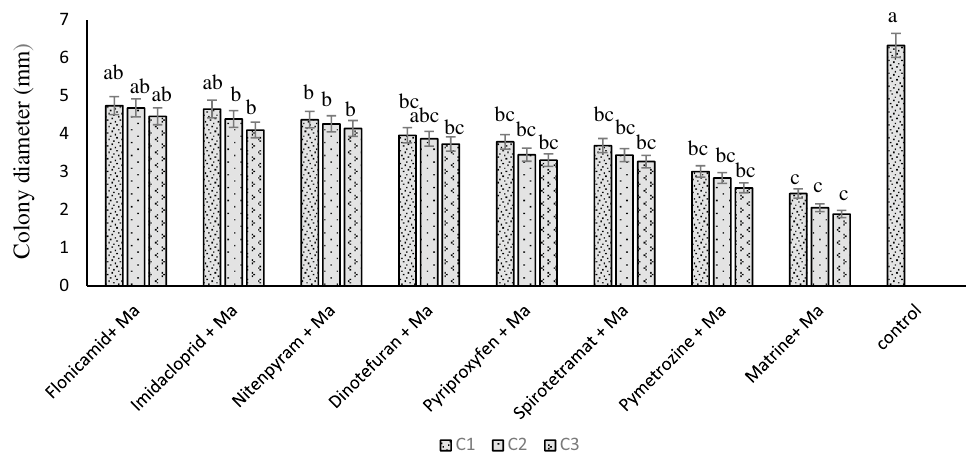
Figure 1. M. Metarhizium anisopliae compatibility test of eight different insecticides at different concentrations. The six insecticides with better compatibility (great colony growth) were chosen for toxicity bioassays. Letters above the bars indicate differences between treatments as determined by ANOVA followed by Tukey HSD. Those not sharing a letter are significantly different (p <